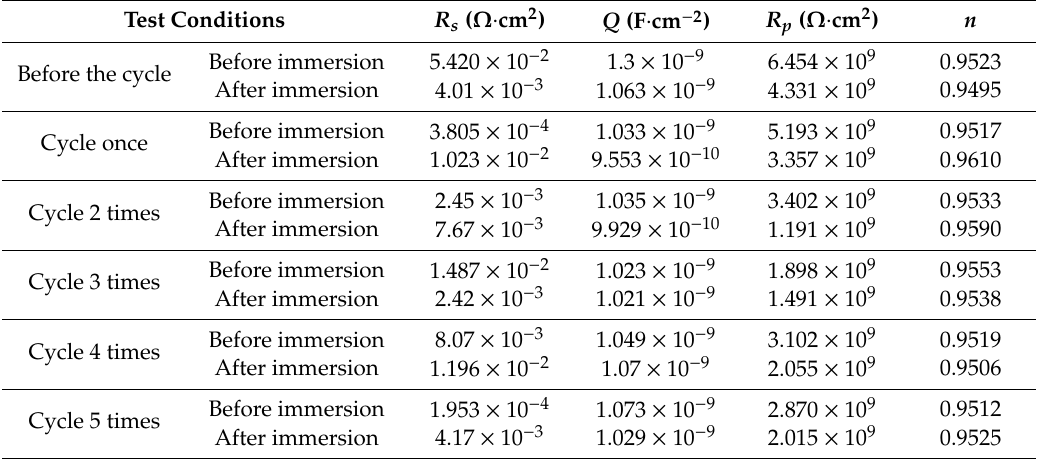
Table 1. The electrochemical fitting parameters of EIS of C-EC / TPU coating for five cycles. Test